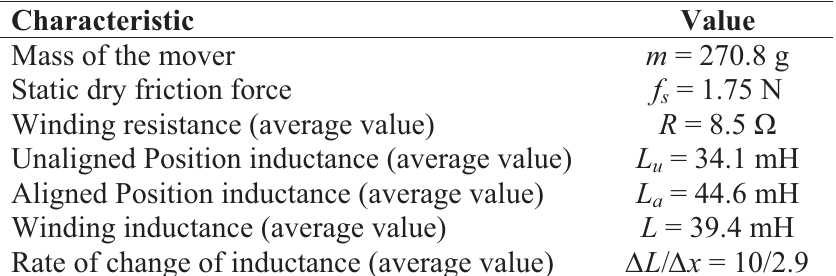
Table 3. Prototype